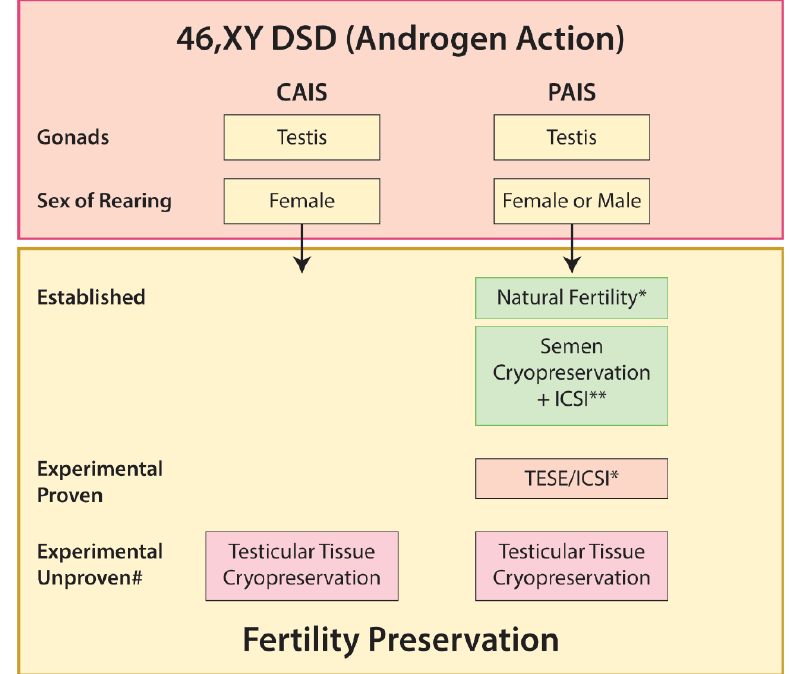
Figure 7. Options for fertility preservation in 46,XY DSD associated with impaired androgen action. * Single case report. ** Single case report (high-dose testosterone). # Potential for gonadal